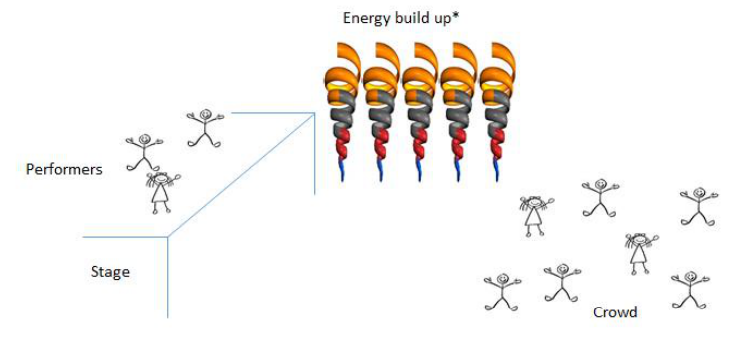
Figure 6. Building up